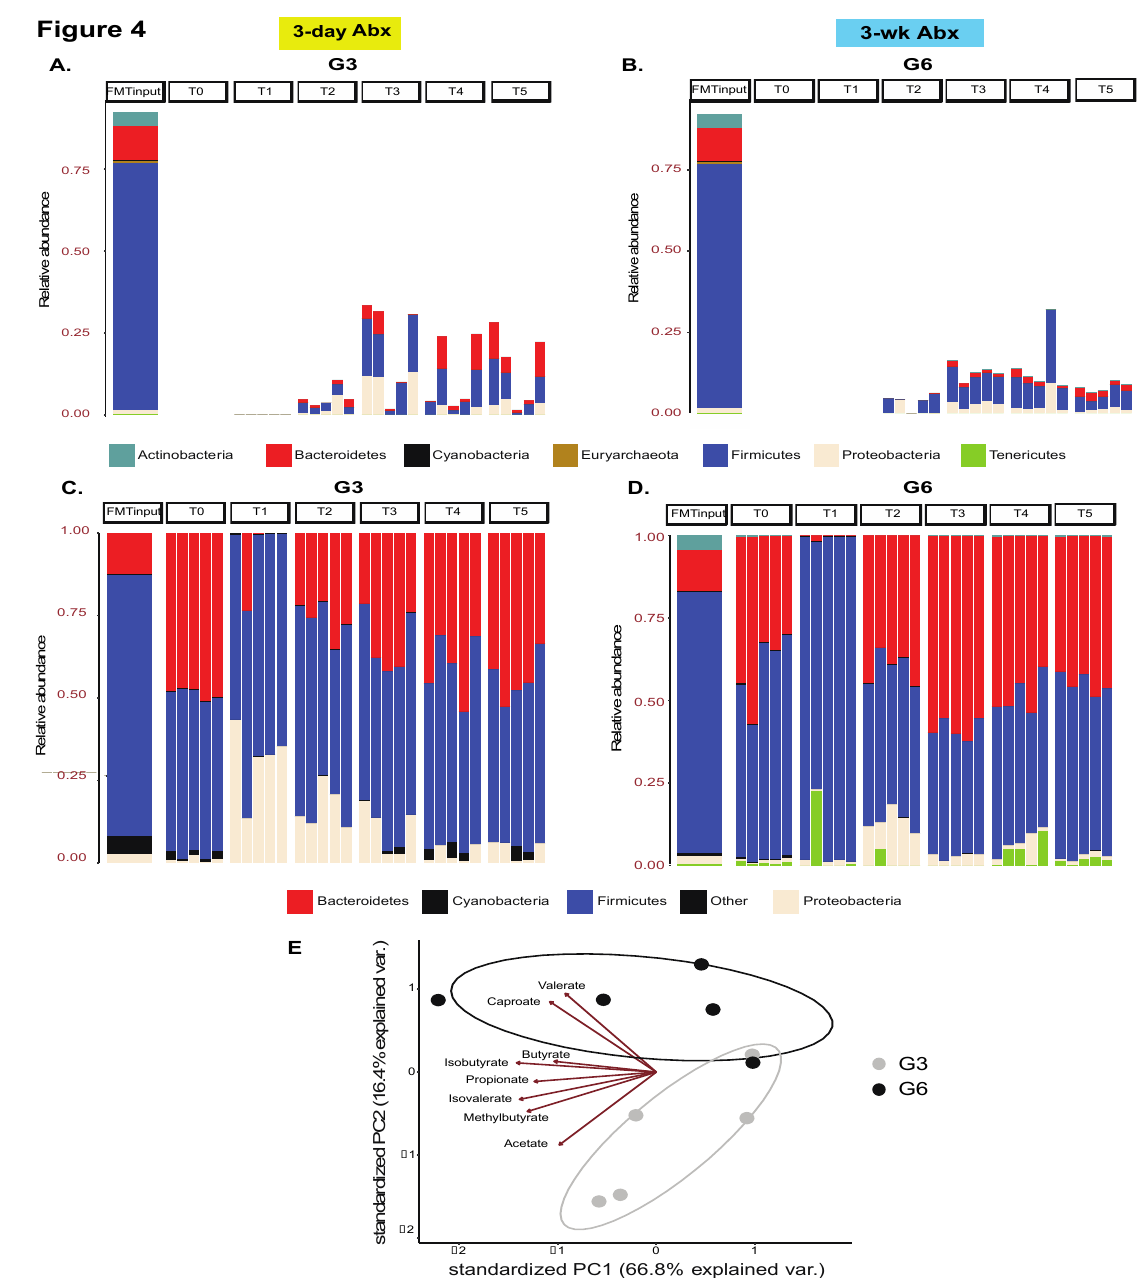
standardized PC1 (66.8% explained var.) Figure 4. Taxonomic landscape. Stacked bar plot showing engraftment of phyla uniquely derived from the input material in recipient mice in ( A ) G3 and ( B ) G6 mice, n = 5 mice/group. See other groups in Figure S7. Additionally, see analogous plot for families in Figure S8. Stacked bar plot comparing the overall taxonomic landscape at the phylum level of the input material and recipient mice over time in ( C ) G3 and ( D ) G6, n = 5 mice/group. Only the most abundant taxa are shown. See other groups in Figure S9. See analogous plot for families in Figures S10 and S11. ( E ) Principal component analysis plot of metabolite abundances. Data points represent individual samples ( n = 5 mice/group) and arrows show an overlaid biplot of loadings for each